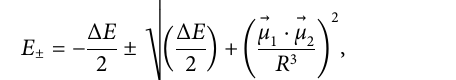
Frontiers in Physics |